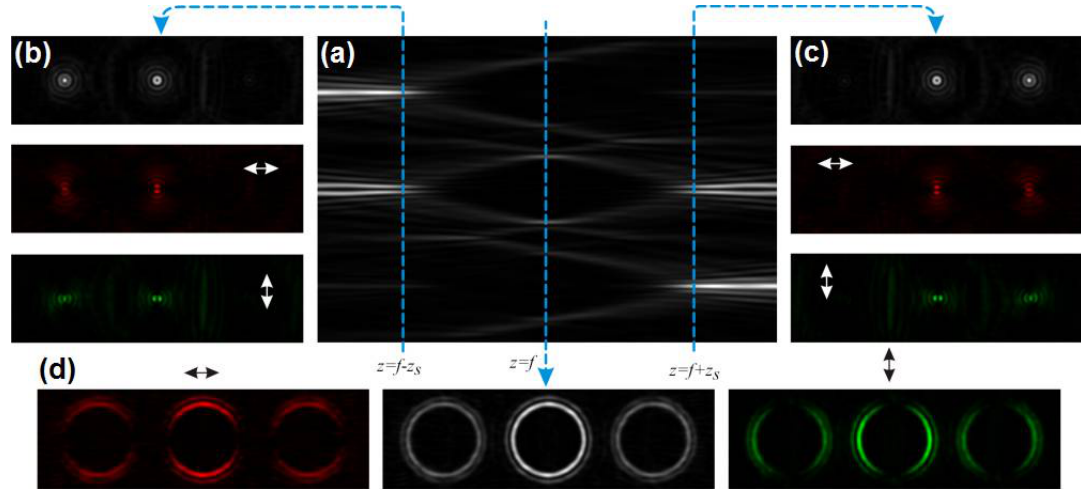
Figure 4. Spatial distributions for a combination of a lens and a binary DOE with transmission function calculated by Equation (7) in the case of azimuthal polarization (red color corresponds to x -component, green color corresponds to y -component): ( a ) longitudinal field distribution in focal domain; ( b ) and ( c ) transversal field distribution at axis before ( z = f − z s ) and after ( z = f + z s ) focal plane, respectively; ( d ) transversal field distribution in the focal plane ( z = f ).